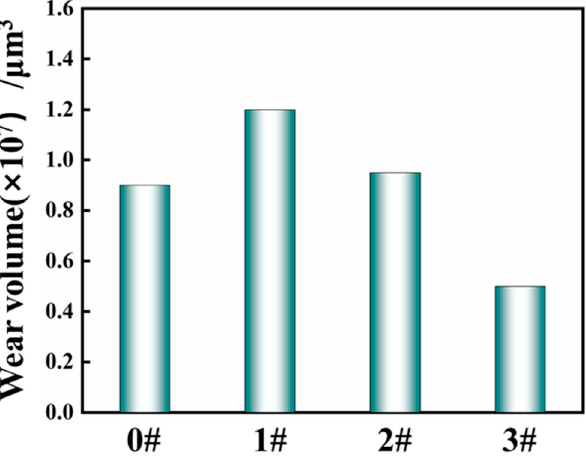
Figure 9. Comparisons of wear volume under 2 N loads.